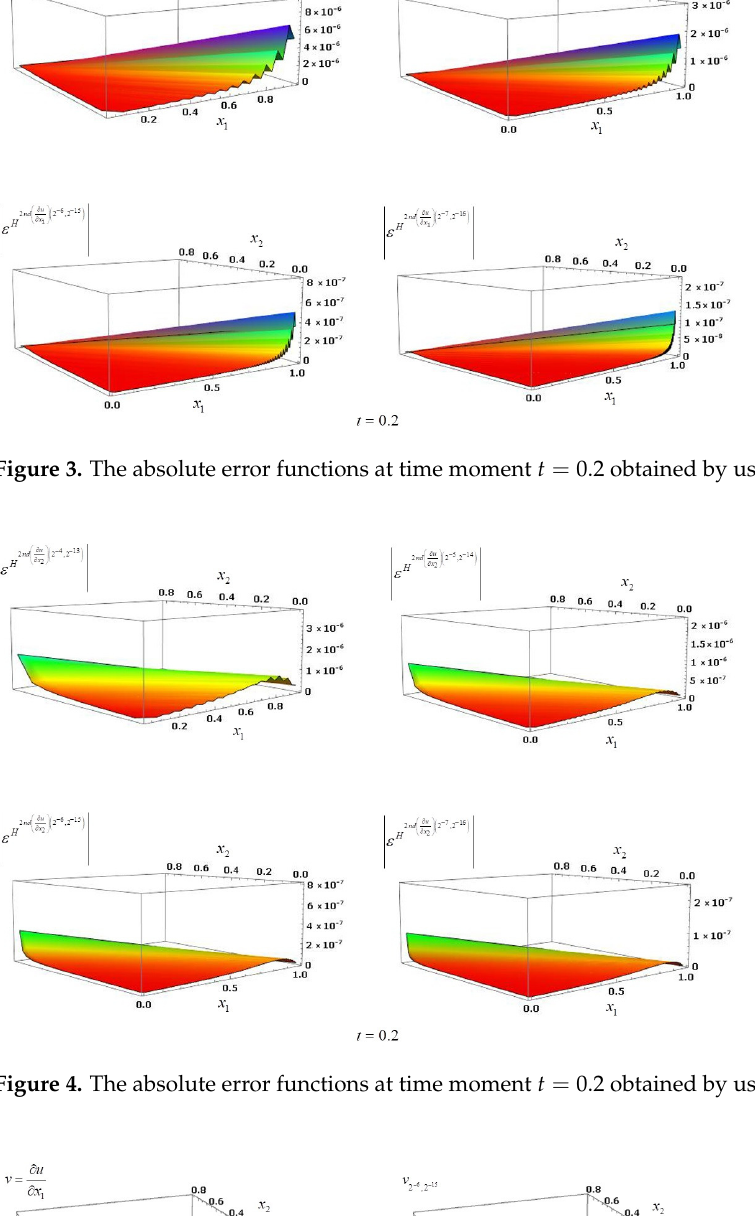
Figure 4. The absolute error functions at time moment t = 0.2 obtained by using H 2 nd